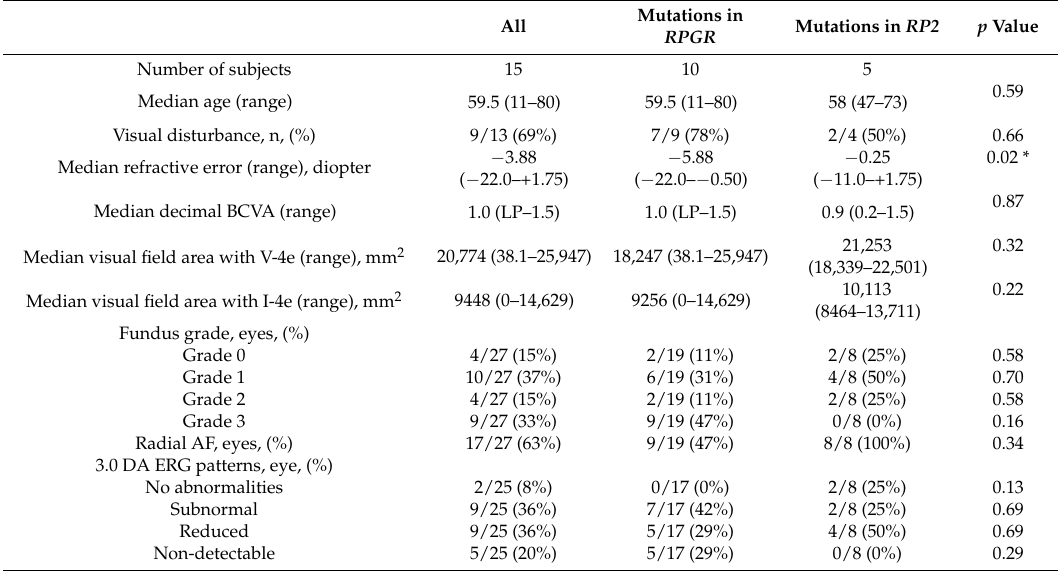
Table 3. Summary of the clinical characteristics of carrier female subjects in the present study.